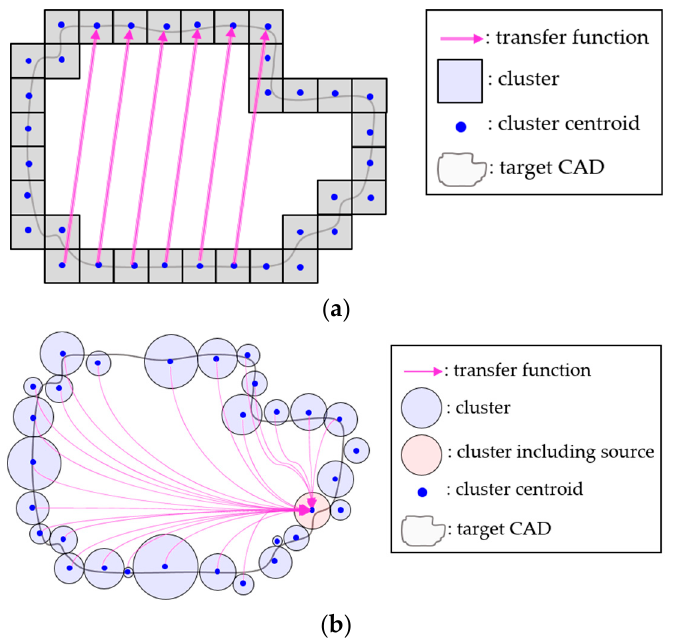
Figure 5. Comparisons of transfer calculation scheme: ( a ) transfer function calculations in the regular cube grouping; ( b ) transfer function calculations in the K-means clustering. Electronics 2020 , 9 , x FOR PEER REVIEW